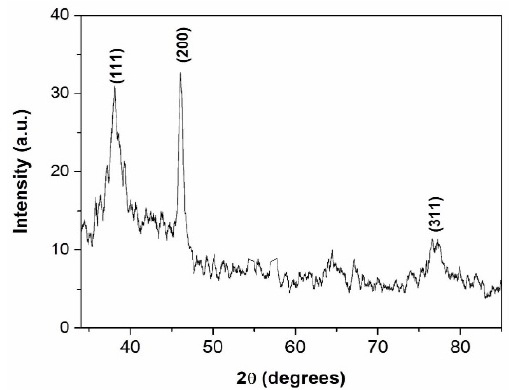
Figure 1. XRD pattern of nanoparticles of Silver.